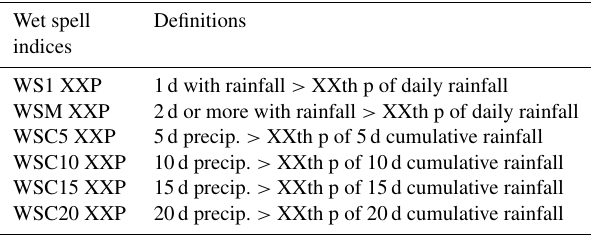
Table 3. Definition of indices for detecting wet spells: XX signifies percentiles 90, 95, 99, and 99.5, and p signifies